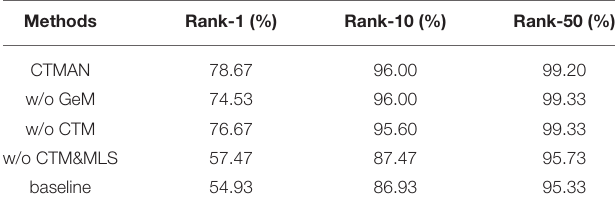
TABLE 2 | Results of the CTMAN, w/o GeM, w/o CTM, w/o CTM&MLS, and baseline on the S1